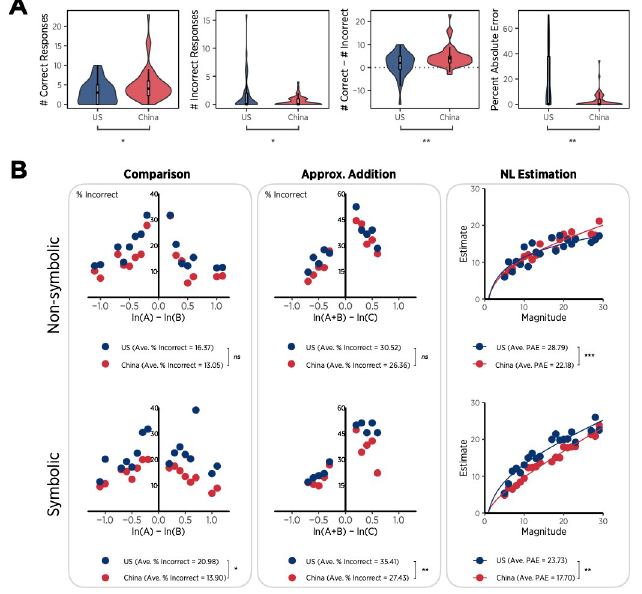
Fig 3. Performance on symbolic arithmetic and numerical magnitude measures. A. Violin plots and boxplots of the four measures of symbolic arithmetic. For each boxplot, the central mark represents the median, the hinges are the first and third quartiles (i.e., the 25 th and 75 th percentiles), and the whiskers extend from the hinges to the smallest or largest values that are within 1.5 × interquartile range (IQR) from hinges—i.e., 1 st quartile-1.5 × IQR to 3 rd quartile +1.5 × IQR. B. Performance on numerical magnitude measures: the mean error rates of comparison and approximate addition, and median responses in number-line estimation.